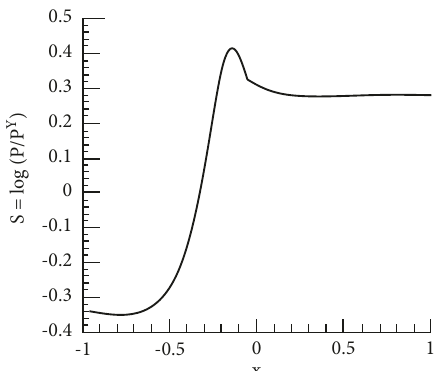
Figure 1: Exact entropy distribution of viscous